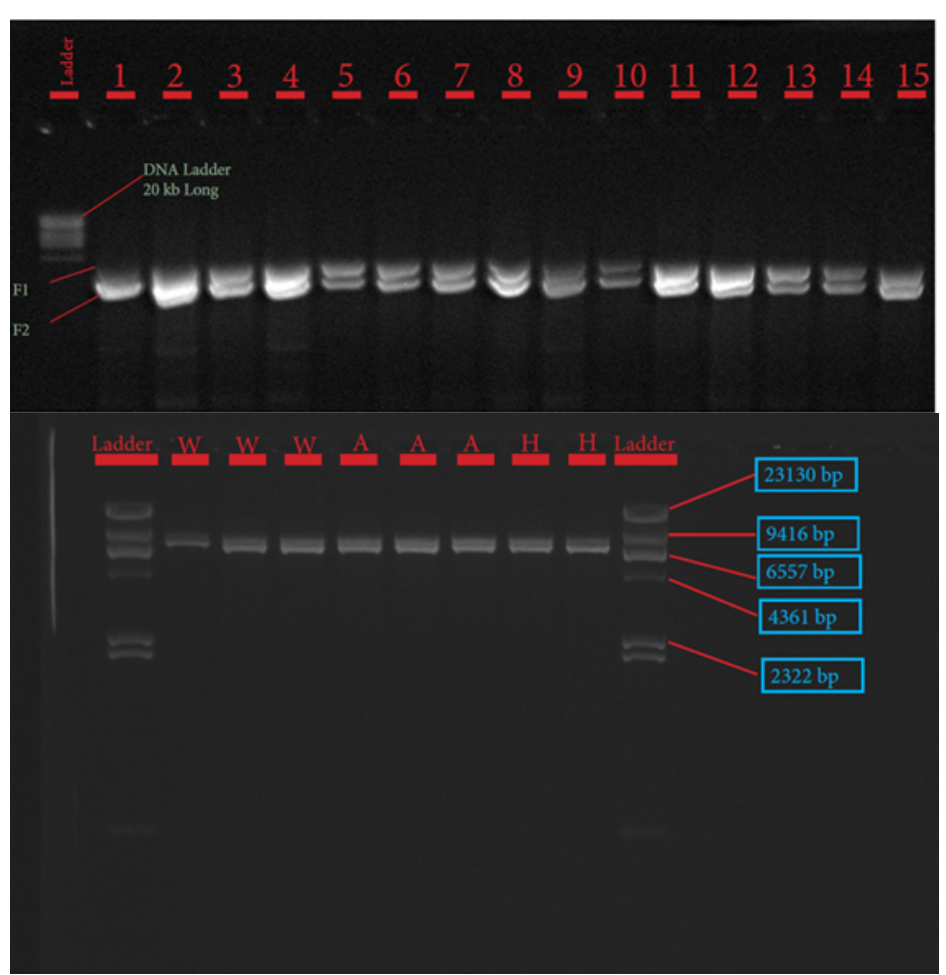
Figure 2. Gel image of fatty acid synthase (FASN) gene fragments 1–2.